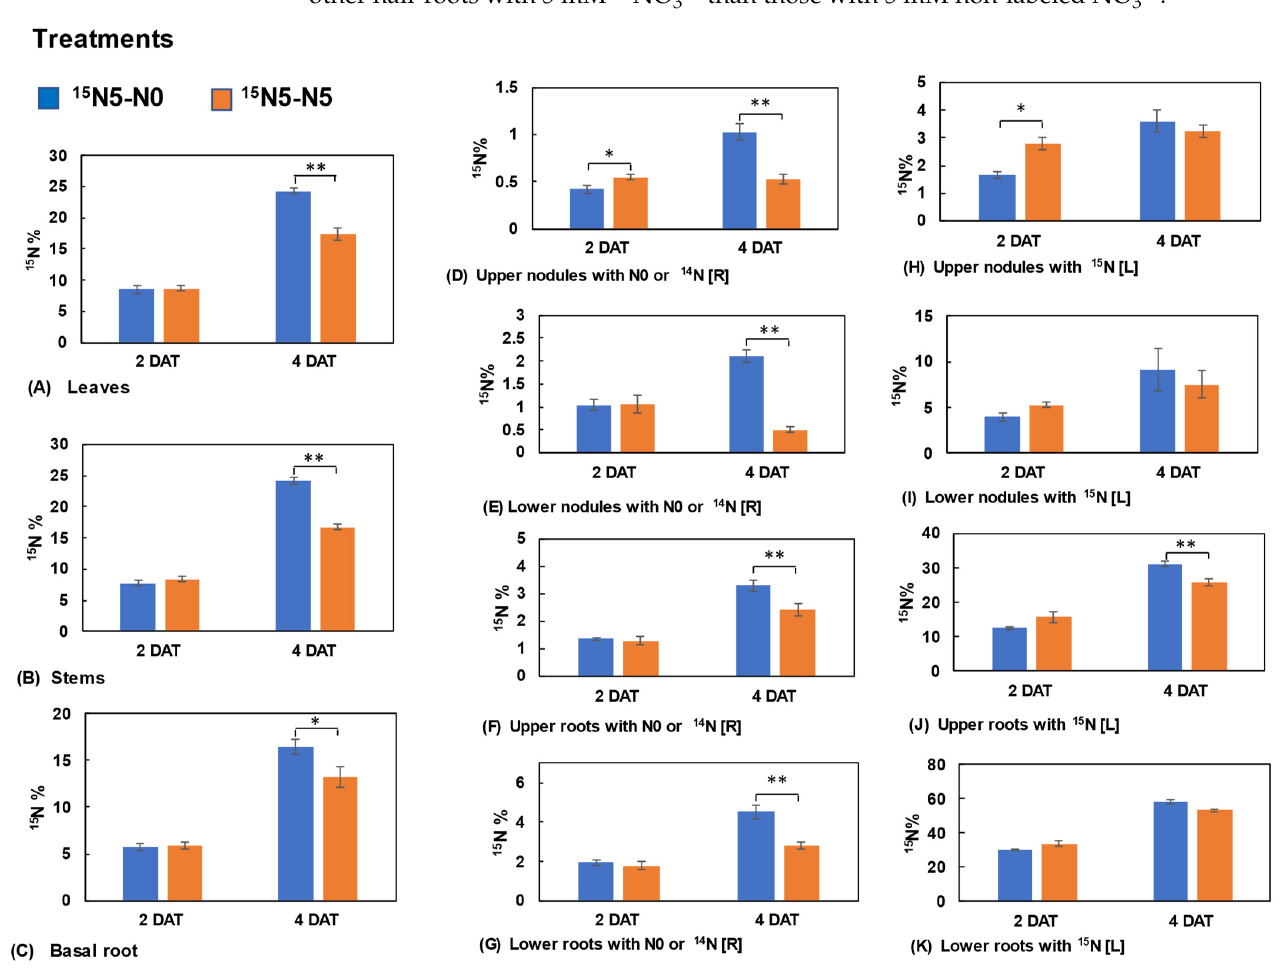
Figure 4. Percentage of N derived from 15 N-labeled 15 NO 3 − in each part of soybean plants with 15 N5-N0 and 15 N5-N5 treatments. ( A ) Leaves, ( B ) Stems, ( C ) Basal roots, ( D ) Upper nodules with N0 or 14 N [R], ( E ) Lower nodules with N0 or 14 N [R], ( F ) Upper roots with N0 or 14 N [R], ( G ) Lower roots with N0 or 14 N [R], ( H ) Upper nodules with 15 N [L], ( I ) Lower nodules with 15 N [L], ( J ) Upper roots with 15 N [L], ( K ) Lower roots with 15 N [L]. *, and ** indicate statistical significance between 15 N5-N0 and 15 N5-N5 treatments at p < 0.05, and p < 0.01 levels based on the Student’s T-test. N = (4). Average ±